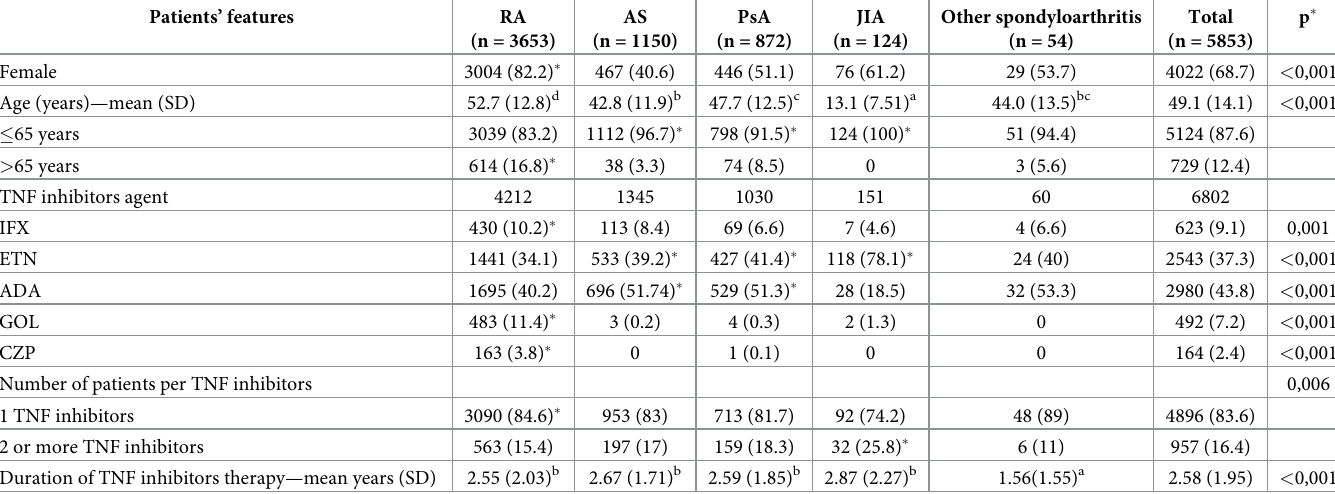
Table 1. Demographic and clinical features in patients in patients exposed to TNF inhibitors. Patients’